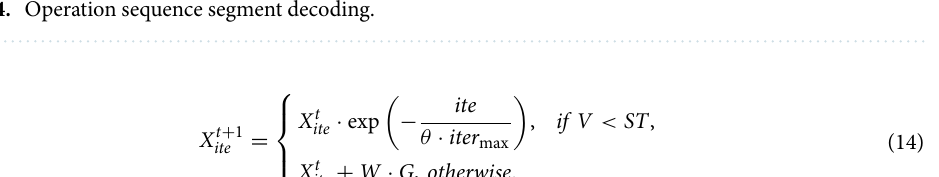
Figure 4. Operation sequence segment